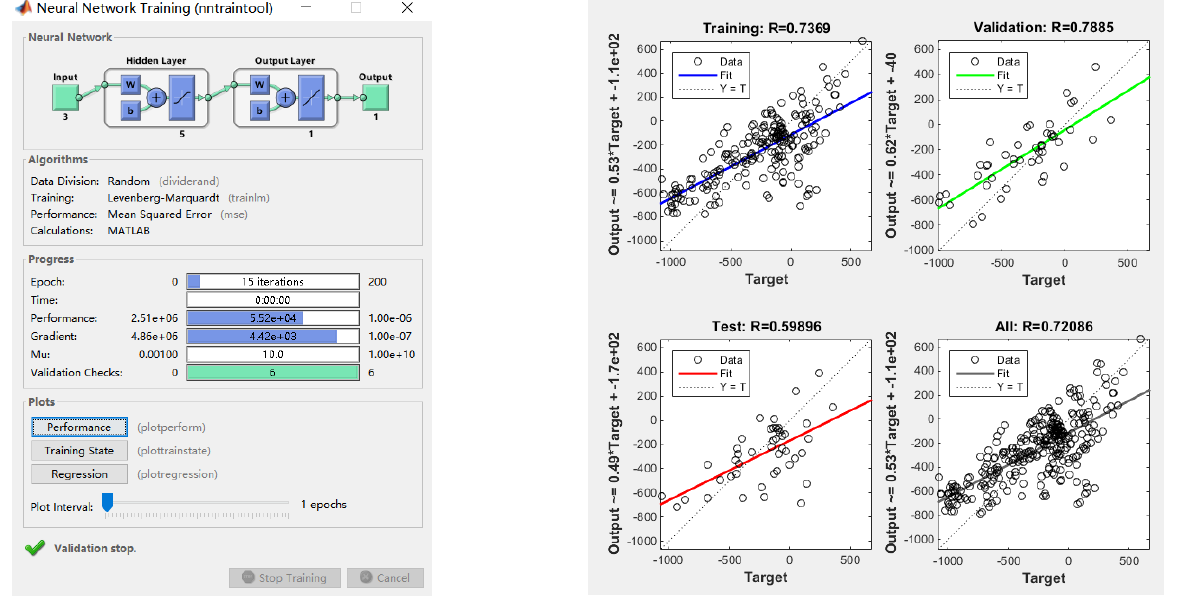
Figure 12. Schematic diagram of abnormal data error.